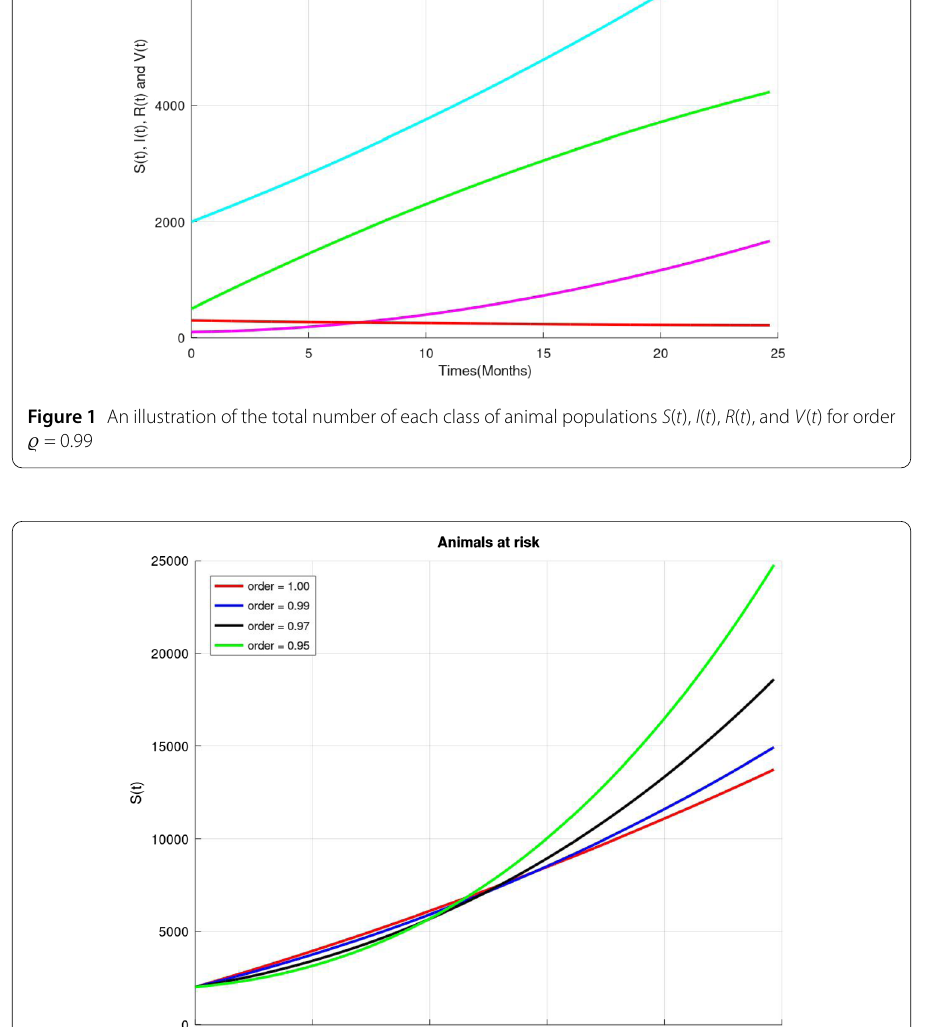
anthrax disease CF -model (8) are obtained by implementing HATM technique. We use distinct values of nonnegative parameters ω = 200, δ = 0.0001, ρ = 0.001, υ = 0.1, ζ = 0.02, (cid:13) = 0.003, and κ = 0.01 and select the initial values ˘ S ˘ V 0 = 500. Note that these numerical values for parameters are taken from the existing data given in [29, 33, 35,